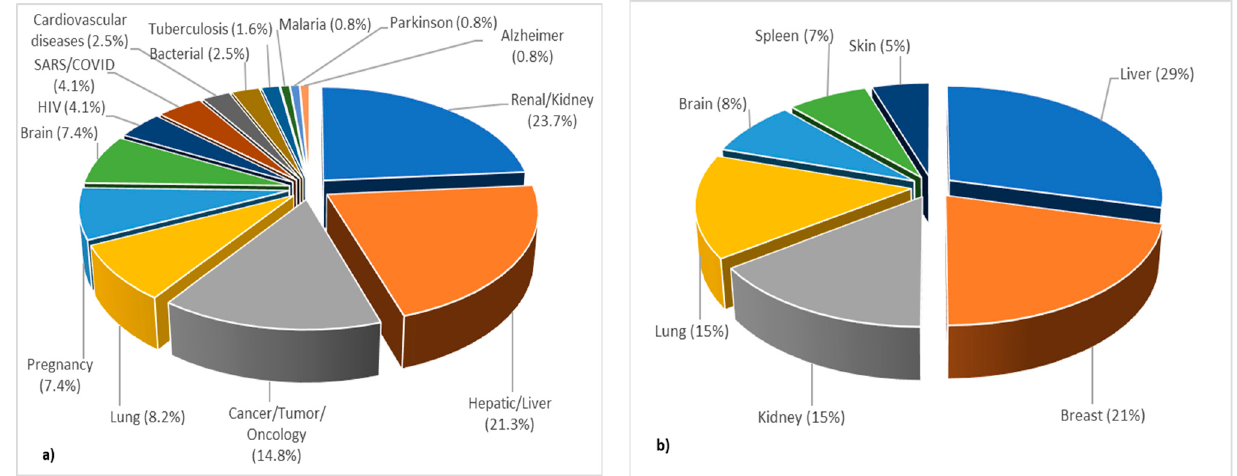
Figure 11. Distribution of PBPK modeling application: ( a ) per disease type; ( b ) per type of cancer within topic 2, expressed as frequency (%), normalized to 100%.